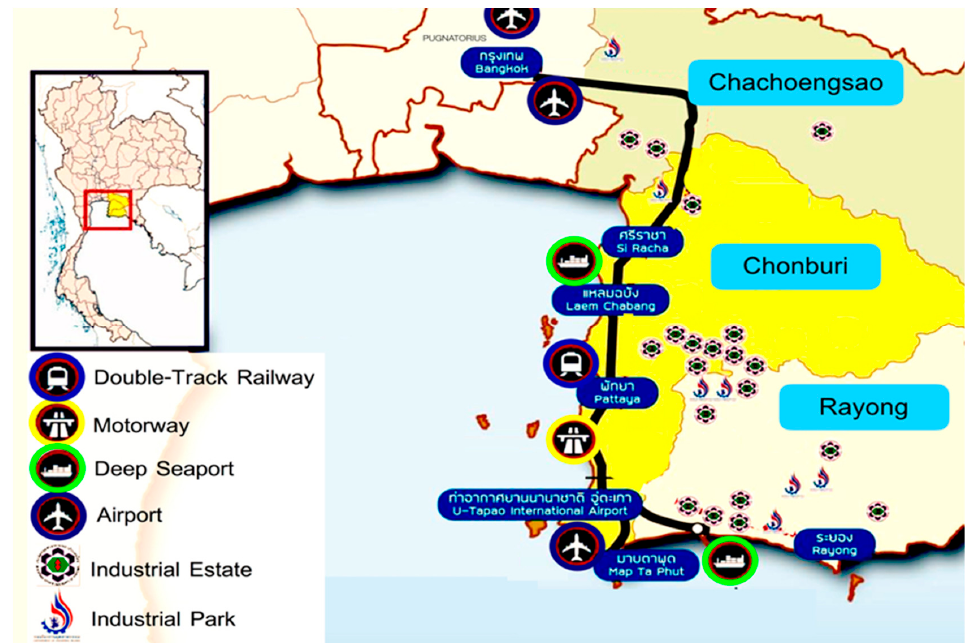
Figure 1. Map showing the three provinces in Eastern Thailand designated for the delivery of the Eastern Economic Corridor (EEC) project. Source: Thailand Board of